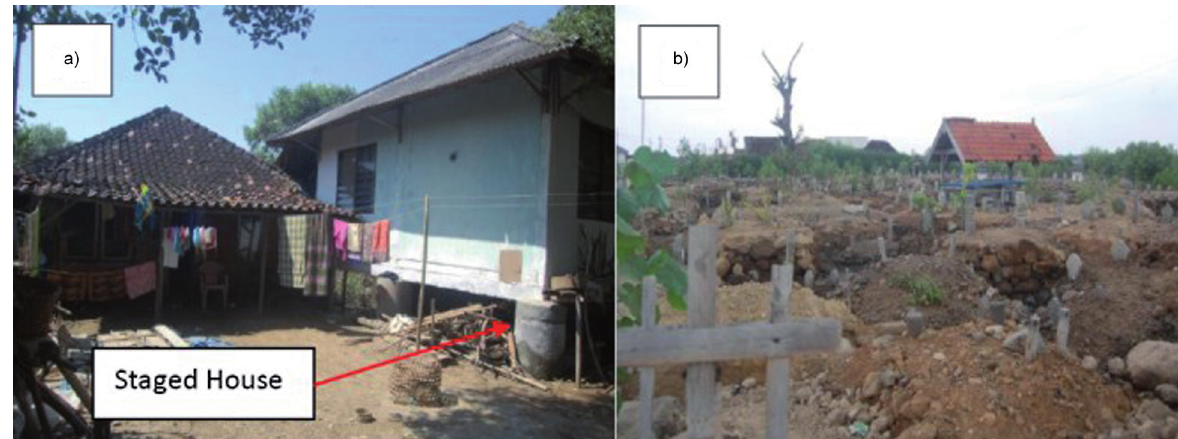
Fig. 8. (a) Staged house built by Tambaksari inhabitants, (b) elevated ground level to maintain the